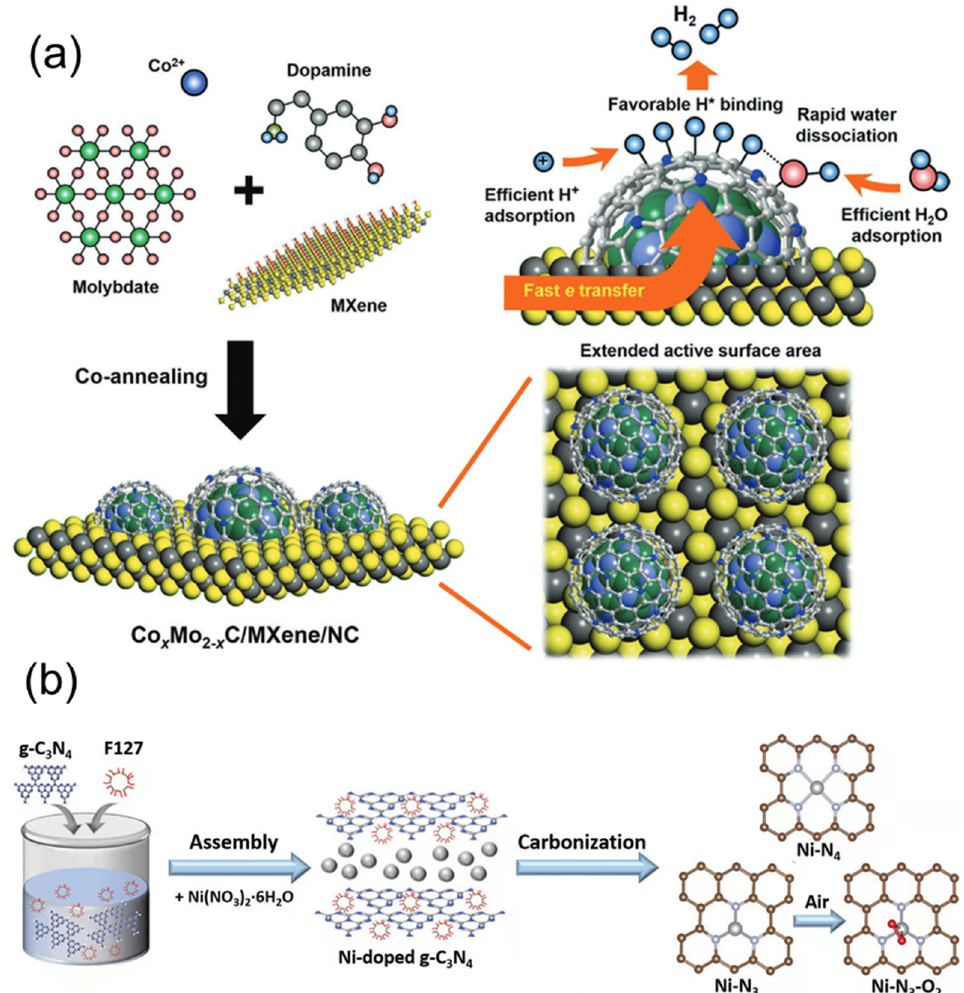
Figure 4. ( a ) The preparation strategy of the Co x Mo 2 − x C/MXene/NC catalyst [26]; ( b ) preparation and analysis of Ni-SA/NC